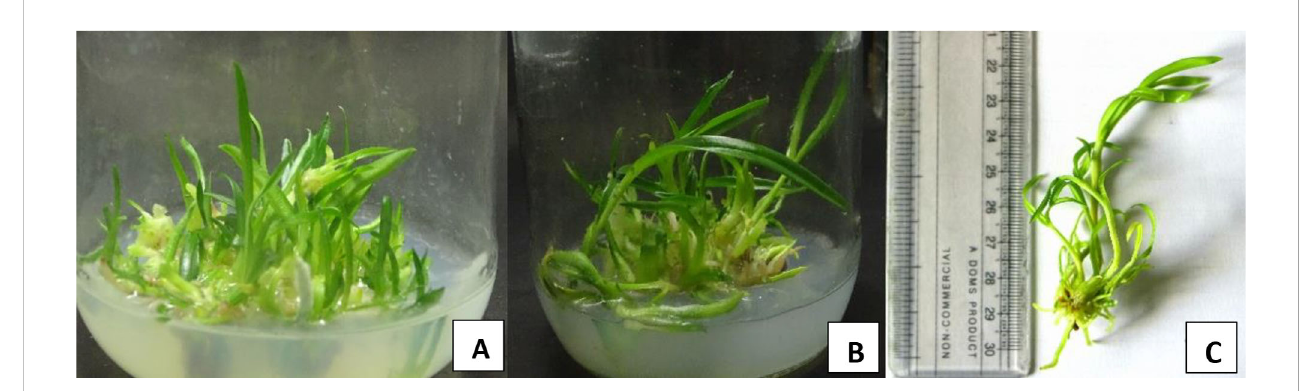
FIGURE 2 (A) From left: shoot development on HMS+10%CW +BAP (1mg/L) + KIN(2mg/L); (B) Root development on FMS+10% CW+NAA (1.5 mg/L); (C) Plantlet developed in HMS+